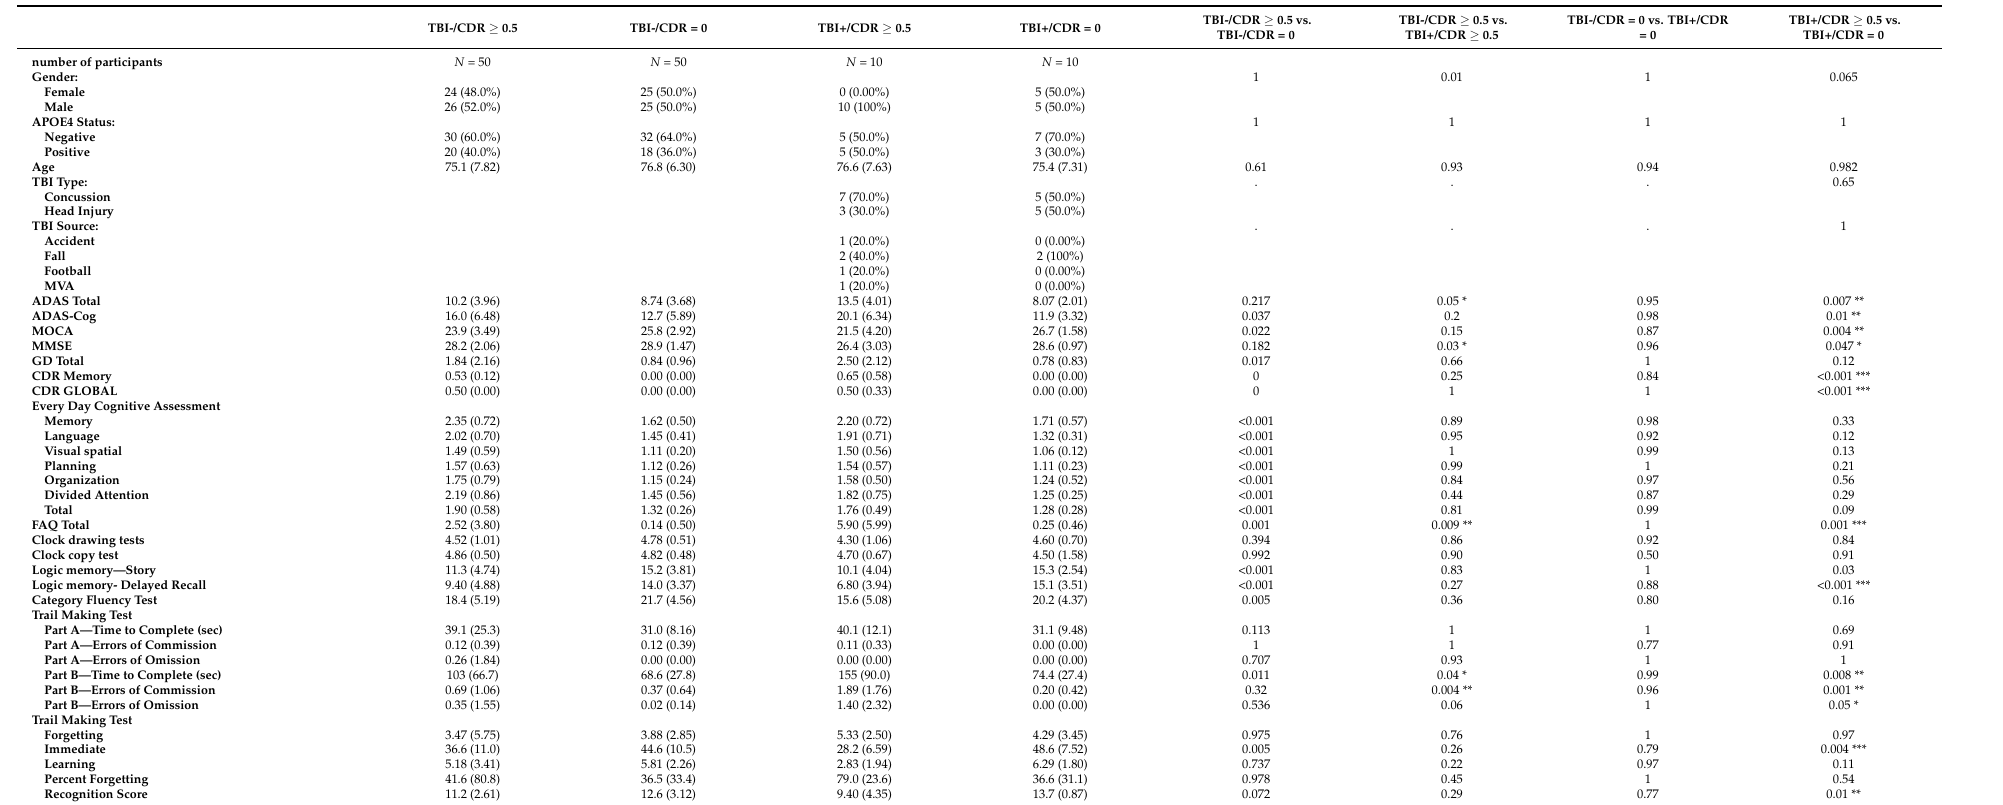
Table 2. Groups demographics and cognitive